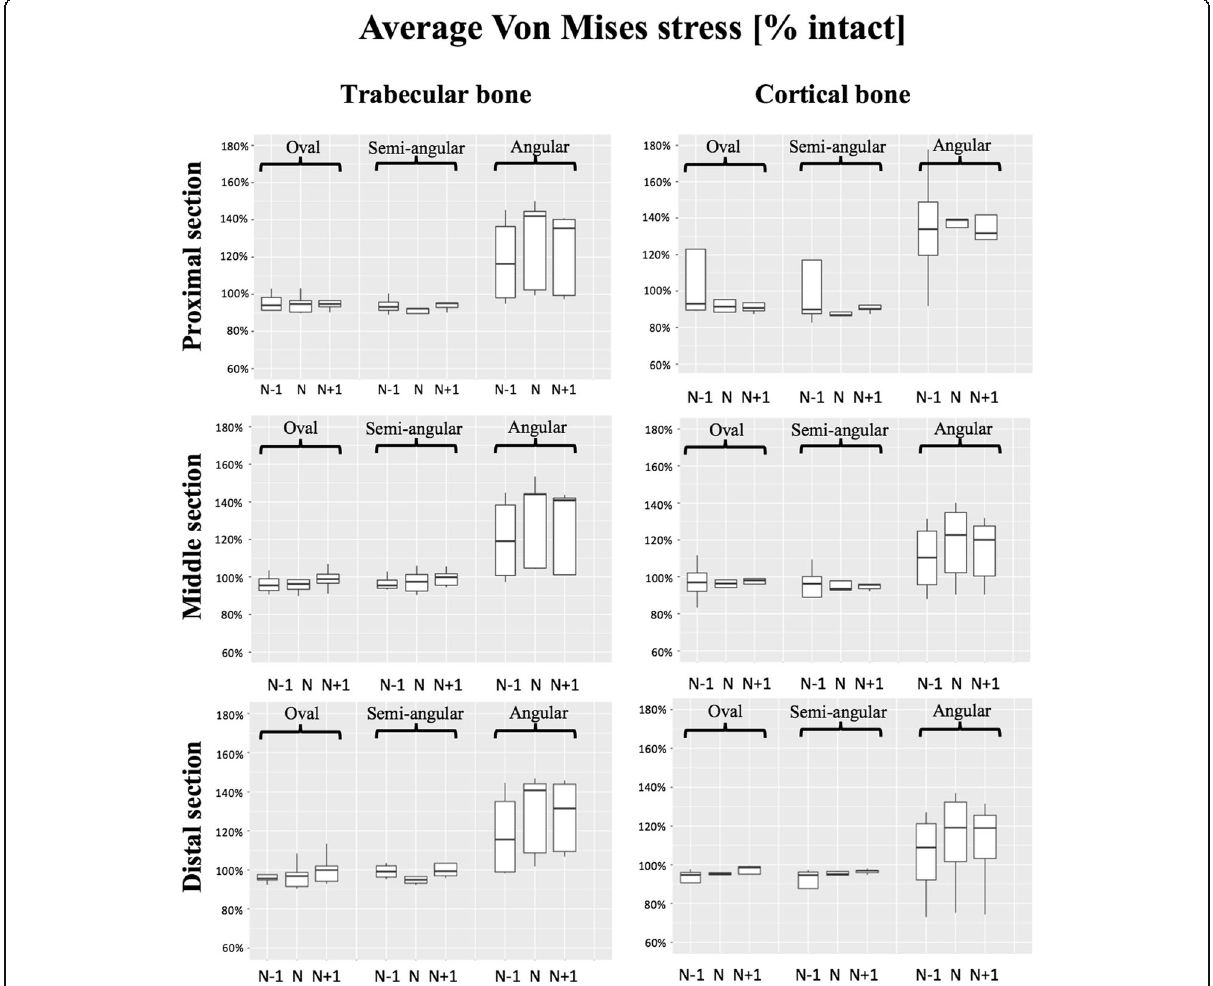
Fig. 4 Average Von Mises stress in trabecular and cortical bone at proximal, middle and distal sections. Average stresses are presented as a percentage of the intact bone stress in each